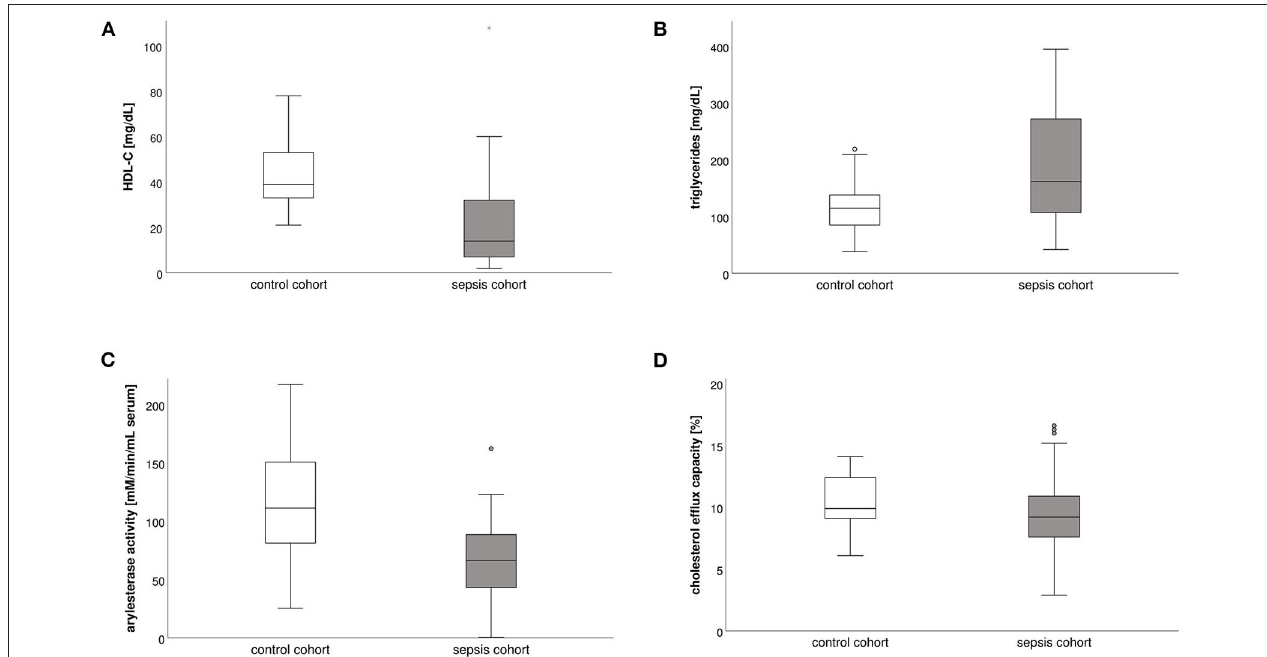
FIGURE 1 | Boxplots of compositional and functional lipid parameters in the sepsis ( n = 53; gray box plot bars) and control cohort ( n = 25; white box plot bars). (A) HDL-cholesterol levels (mg/l); (B) triglyceride levels (mg/l); (C) arylesterase activity (mM/min/ml serum); (D) cholesterol efflux capacity (%). AEA, arylesterase activity; HDL-C, high-density lipoprotein cholesterol.